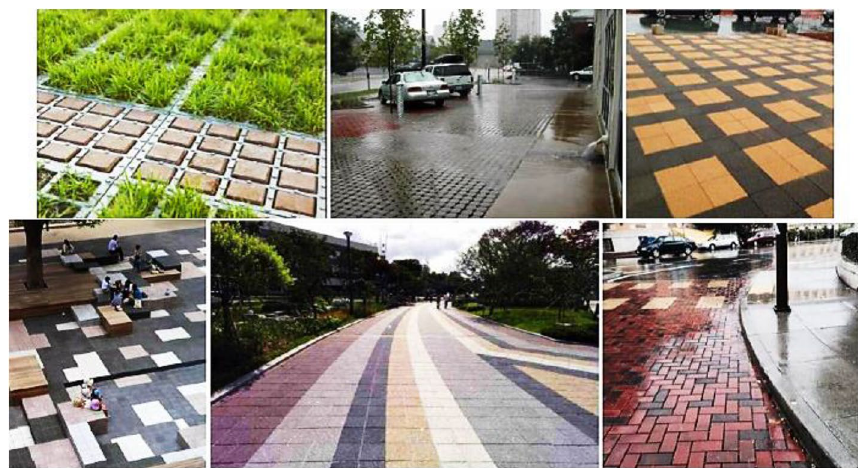
Fig. 7 Nature-based solution applications. Ref: Đurakovac et al. [24]